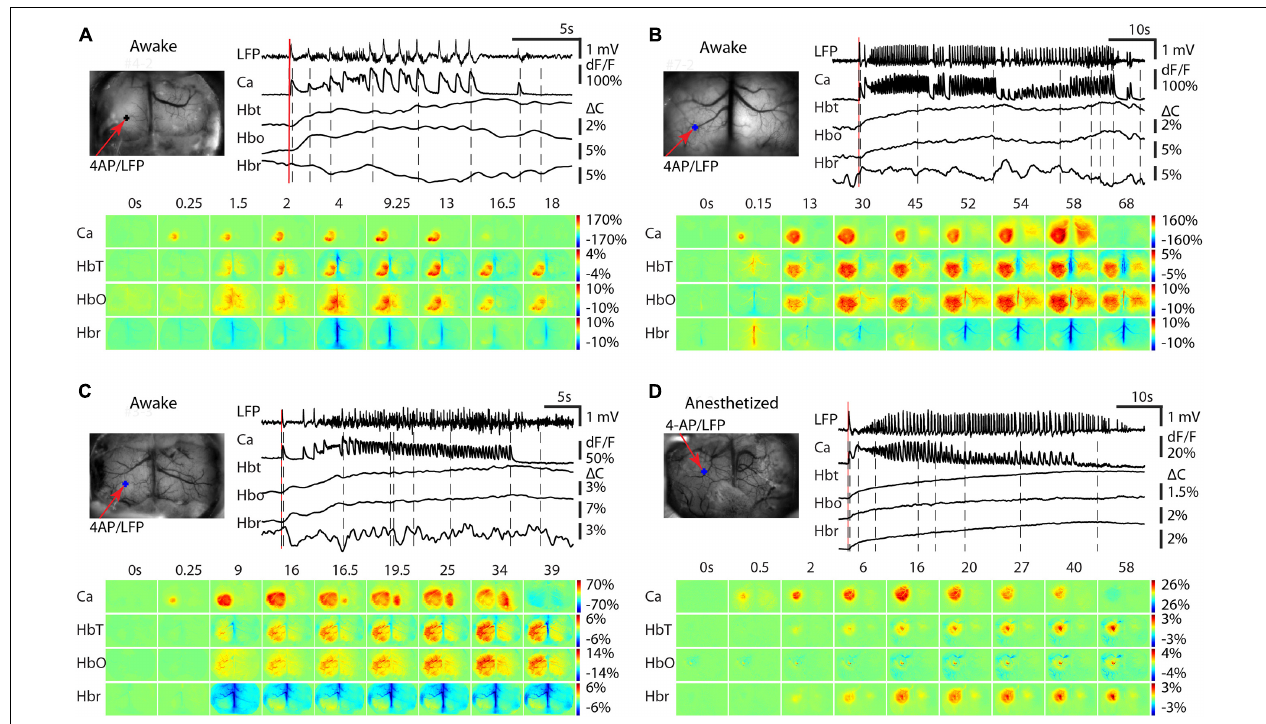
FIGURE 4 | Contralateral propagation of calcium and hemodynamic signals in awake and isoflurane-anesthetized mice. In awake mice, three different propagation patterns were observed. (A) Calcium and hemodynamic signals remain ipsilateral. (B) Calcium and hemodynamic signals propagate to the contralateral hemisphere by jumping to the contralateral homotopic area. (C) Calcium and hemodynamic signals propagate to the contralateral hemisphere smoothly crossing the midline. (D) In anesthetized mice, the calcium and hemodynamic signals remained predominantly ipsilateral Small hemodynamic signals were recorded contralaterally. For each subpanel, the top left is the field of view. The red arrow shows the 4-AP/LFP electrode and the blue dot shows the POI from the 4-AP injection site. Top right, the LFP, calcium, and hemodynamic traces from the POI. Bottom, the spatiotemporal dynamics of the calcium and hemodynamic